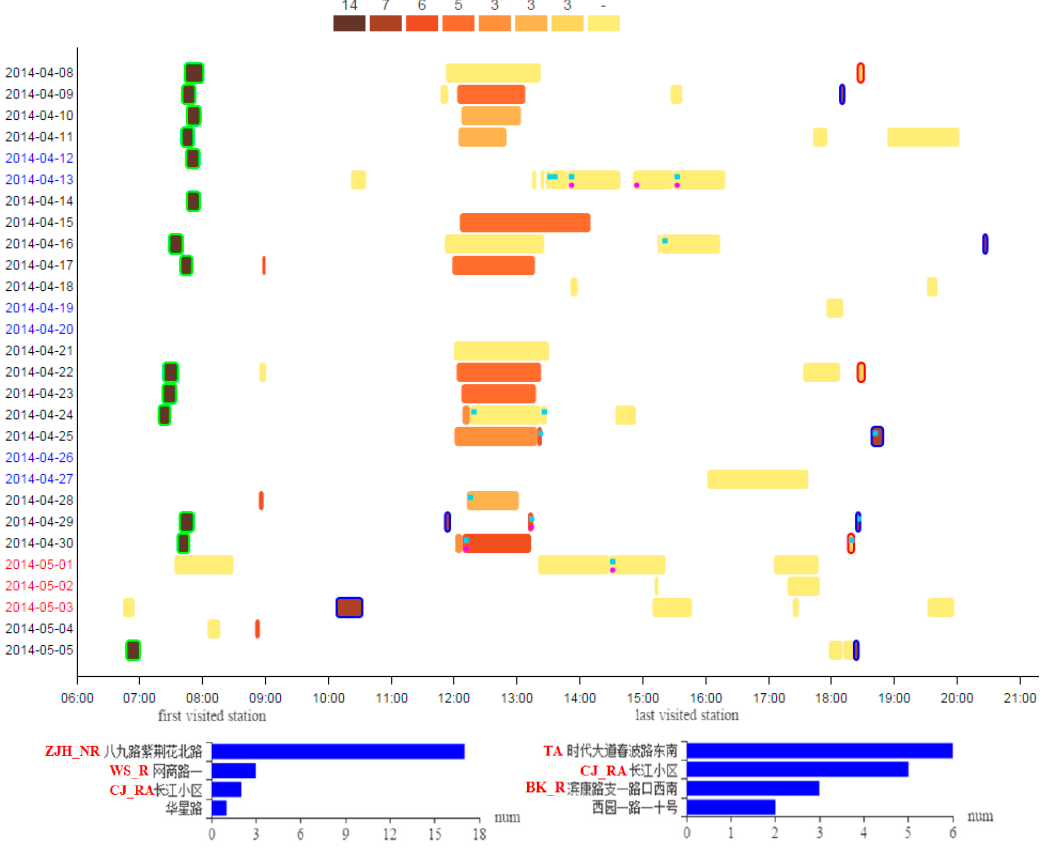
Figure 8. The user hire sequence view in example B.